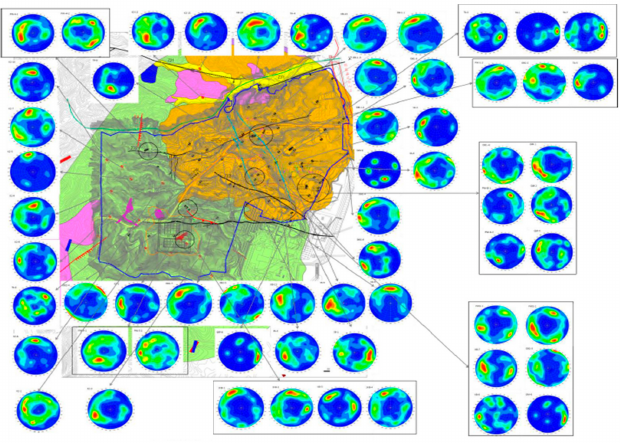
Figure 6. Stereonet contour plots of open/filled fracture orientation and dip obtained from the BHTV